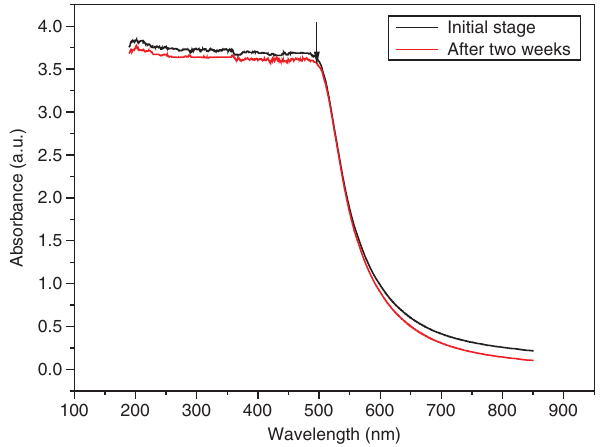
Figure 3: UV-visible spectrum of Cu nanoparticle sol at initial stage and after 2 weeks.